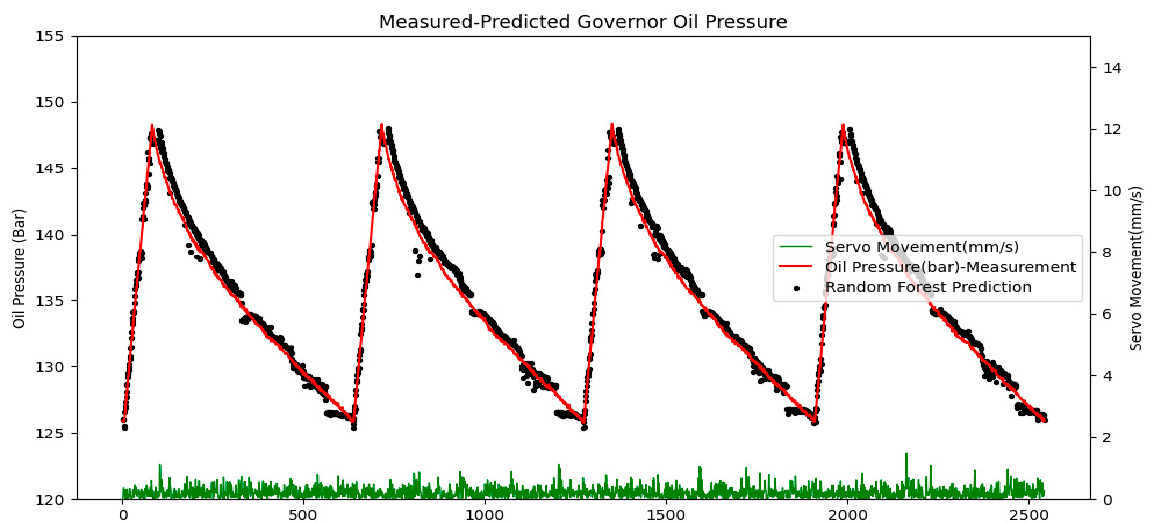
Figure 20. Predicted–measured governor system pressure under constant load.